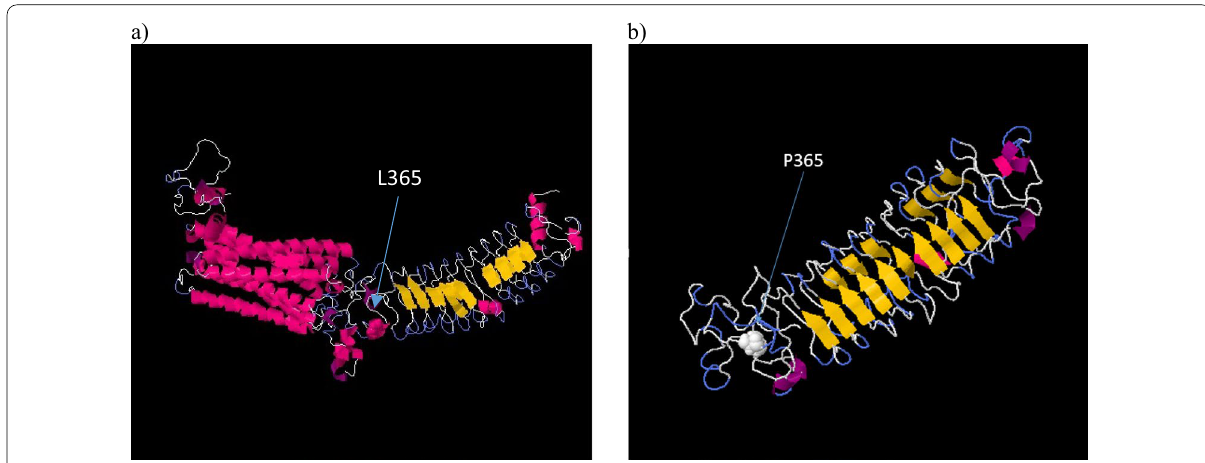
Fig. 3 The 3D structure model of the LHCGR protein a Wild type LHCGR, and b Mutant LHCGR that alters the receptor structure. The arrow indicates amino acid 365, leucine in the wild type and proline in the mutant receptor,